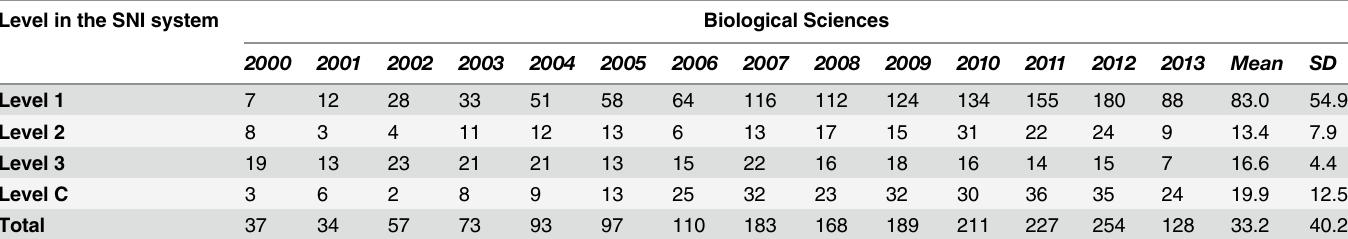
Table 7. Distribution of the average of papers produced by year by the Mexican Diaspora vs. level in the SNI of the biological sciences area. Level in the SNI